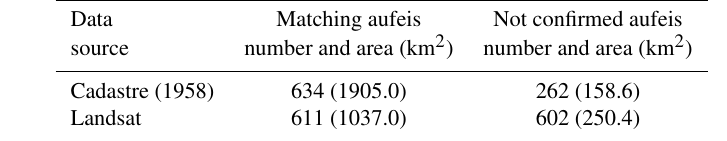
Table 3. Data correlation of aufeis based on the Cadastre (1958) and the Landsat images.